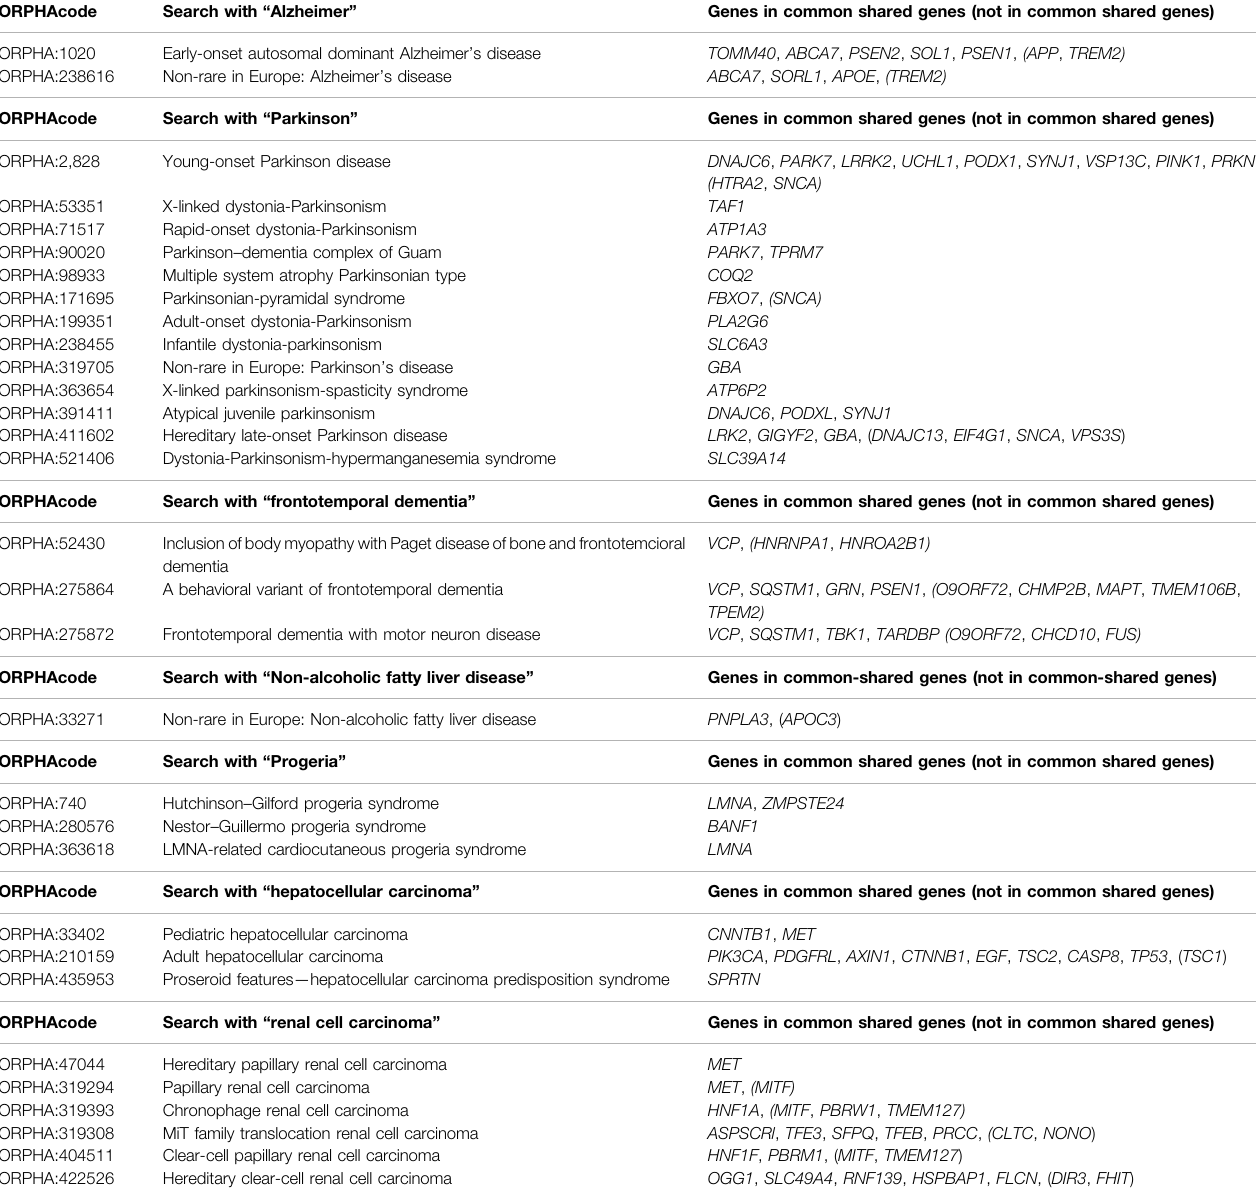
TABLE 3 | List of genes related to some age-related